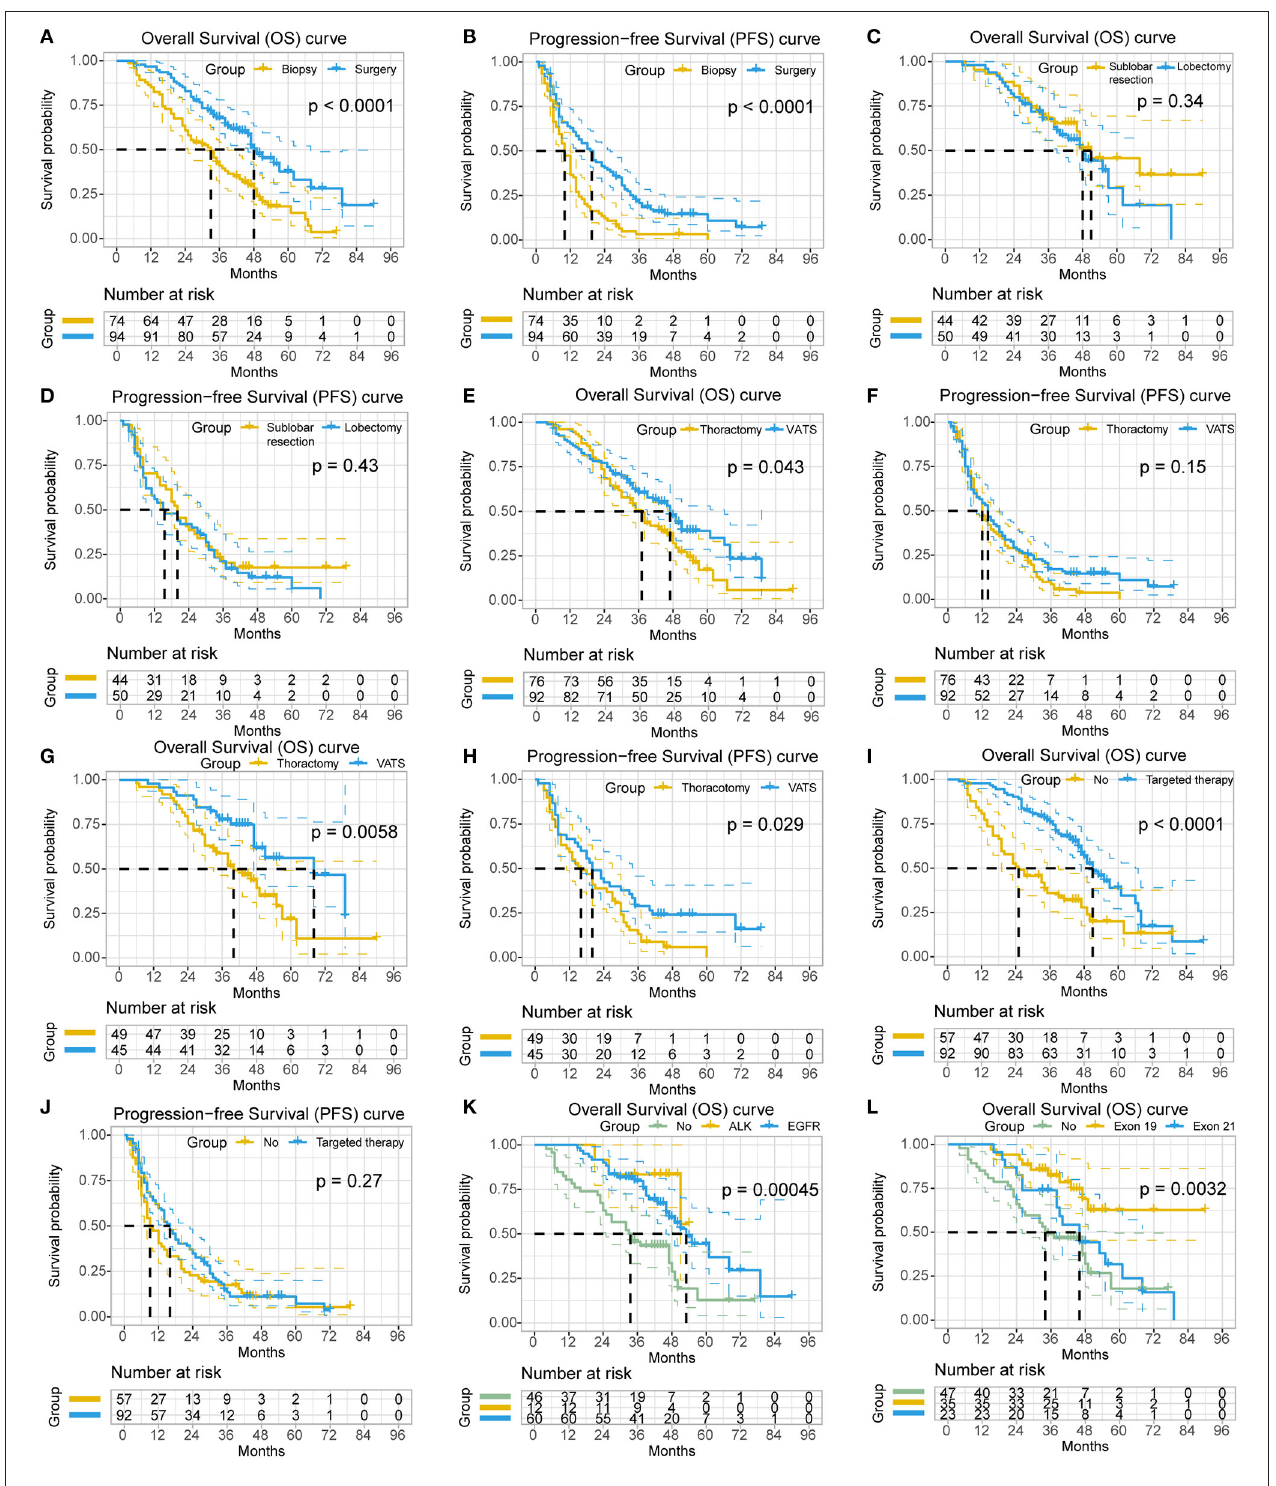
FIGURE 1 | The survival analyses of the clinicopathological characteristics in non-small cell lung cancer (NSCLC) patients with unexpected pleural dissemination (PD). (A,B) Comparison of postoperative overall survival (OS) and progression-free survival (PFS) of NSCLC patients with unexpected PD in primary tumor resection group and biopsy alone group. (C,D) Comparison of OS and PFS of NSCLC patients with unexpected PD in sublobar resection group and lobectomy group. (E,F) Comparison of OS and PFS of NSCLC patients with unexpected PD in video-assisted thoracic surgery (VATS) group and thoracotomy group. (G,H) Subgroup analysis of OS and PFS of NSCLC patients with unexpected PD in resection group with or without VATS. (I,J) Comparison of OS and PFS of NSCLC patients with